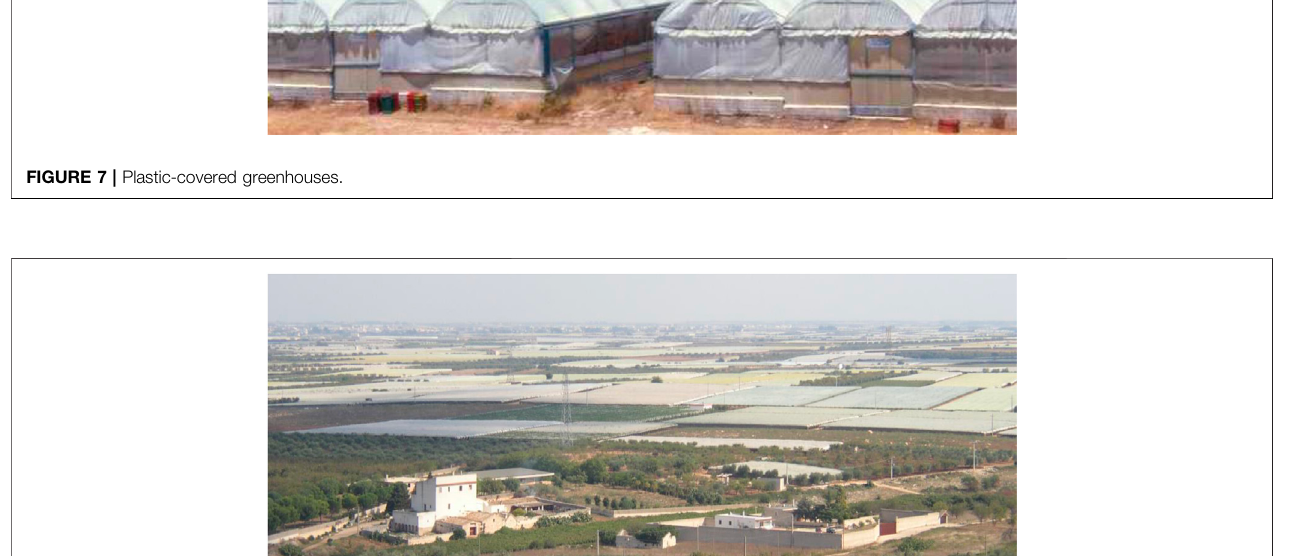
FIGURE 8 | Plastic covers impacting the rural